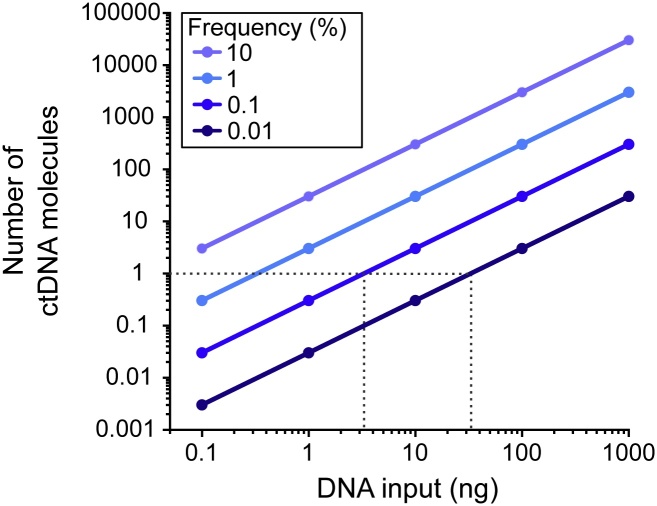
Limit of detection for ctDNA analysis. The ability to detect ctDNA molecules depends on total DNA input. To calculate the relationship between DNA input (ng DNA) and molecule numbers we assumed that the weight of a human haploid genome is 3.3 × 109bp × 650Da= 2.15 × 1012 Da, where 650 Da corresponds to the average weight of a base-pair and that one Da equals 1.67 × 10−24 g. Consequently, the weight of human genome is 3.59 × 10-12 g, i.e., 1 ng human genomic DNA contains about 278 haploid genomes [26,27]. Dashed horizontal line indicate one ctDNA molecule.